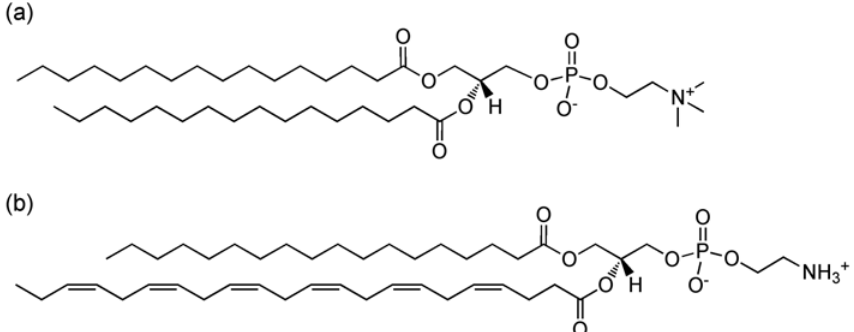
Figure 1. Molecular structures for the lipids used in this study: ( a ) 1,2-dipalmitoyl- sn - glycero-3-phosphocholine (DPPC); ( b ) 1-palmitoyl-2-docosahexaenoyl- sn -glycero-3- phosphoethanolamine